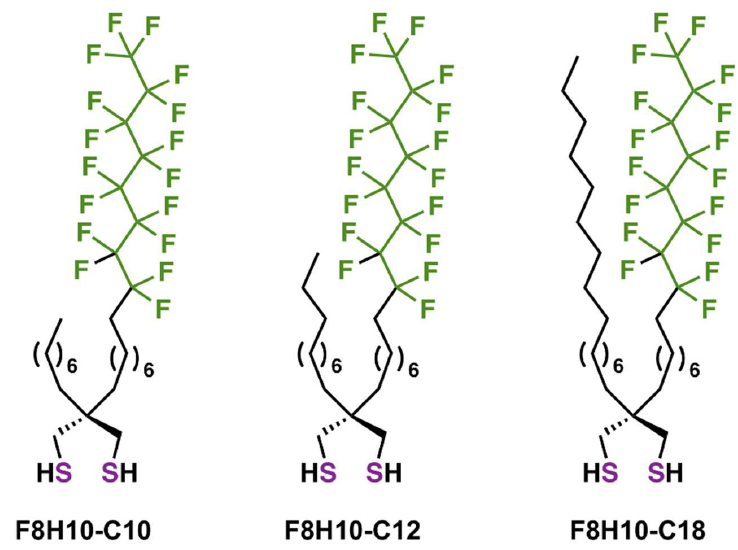
Figure 1. Molecular structures of the unsymmetrical partially fluorinated spiroalkanedithiols ( F8H10-Cm , m = 10, 12, and 18) examined in the present study: F8H10-C10 , F8H10-C12 , and F8H10-C18 .